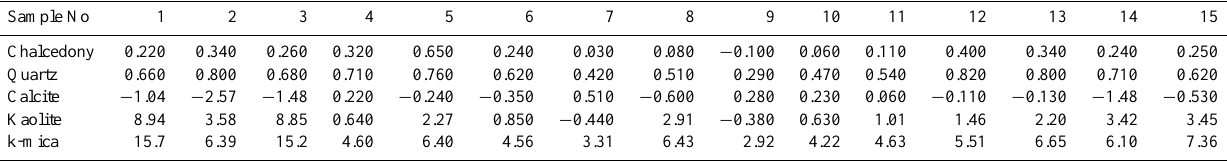
Table 4. Values of the saturation index for various mineral species using the PHREEQE (Parkust et al., 1980) code. Sample No